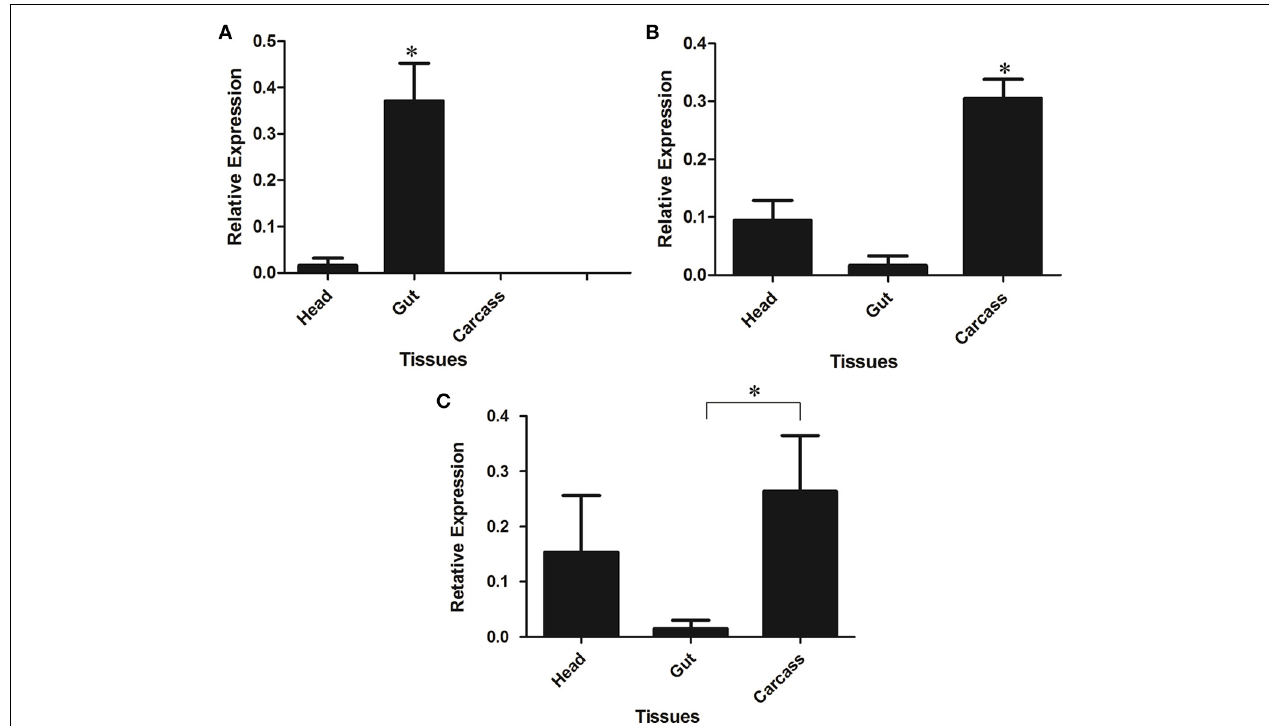
FIGURE 7 | Relative expression of GHF16 (A) β -1,3-glucanase (Ll β Glu) and (B) β -glucan binding proteins LlGBP1 and (C) LlGBP2 in different tissues of Lutzomyia longipalpis L4 larvae as determined by Multiplex RT-PCR (Ribosomal protein 60 used as constitutive